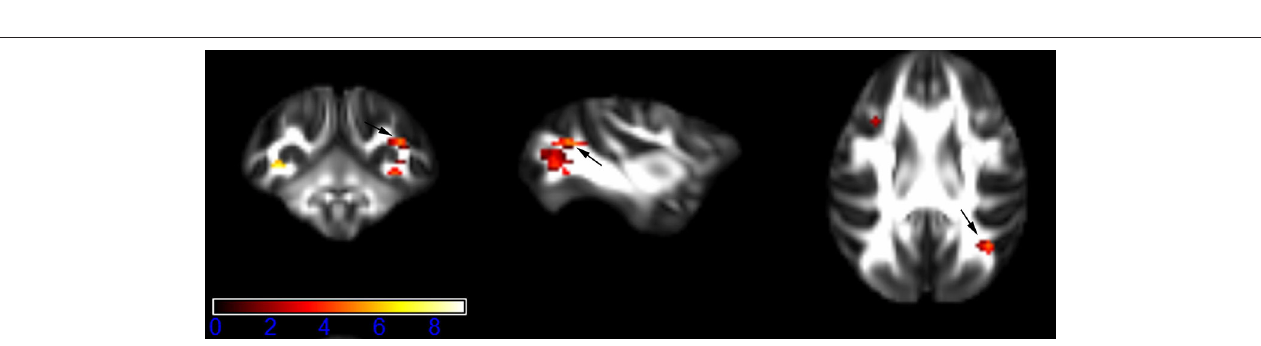
FIGURE 6 | Areas in retrolenticular limb of the internal capsule (RLIC, right side) with reduced fractional anisotropy values in the chronic ketamine exposure group compared to controls at p < 0.005 (in red; uncorrected). The anatomical underlay is DTI-based monkey brain image template (UWRMAC-DTI271) FA map with white matter atlas. Figure from left to right side is coronal view, sagittal view, and axial view of the images, respectively. The color bar represents the t -value.